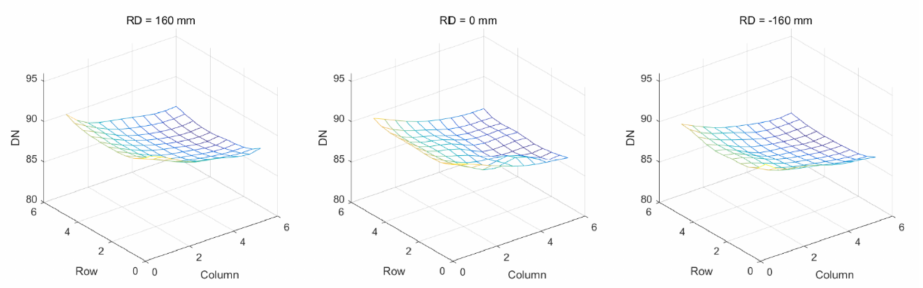
Figure 9. Irradiance instability of the SSLS in 10 min.